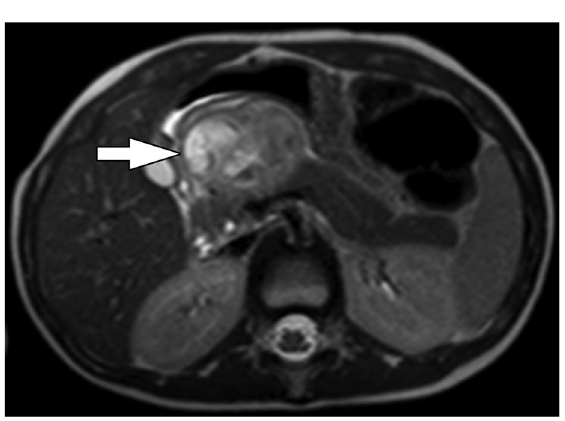
FIGURE 7 Pancreatic NET. Axial T2-weighted MRI shows a heterogeneously hyperintense exophytic mass arising from the neck of the pancreas (arrow). The upstream pancreatic body and tail are Normal and there is no duct dilation to suggest duct